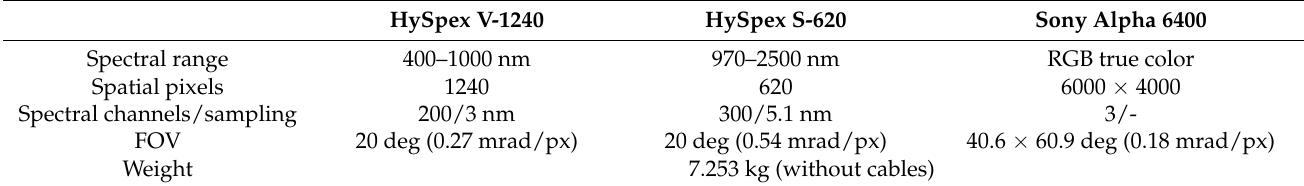
Table 1. Sensor parameters of the HySpex Mjolnir VS-620 combined hyperspectral imaging and photogrammetry system deployed in the study. Data from the V-1240 were spatially downsampled (binned) to match the S-620 sensor for this